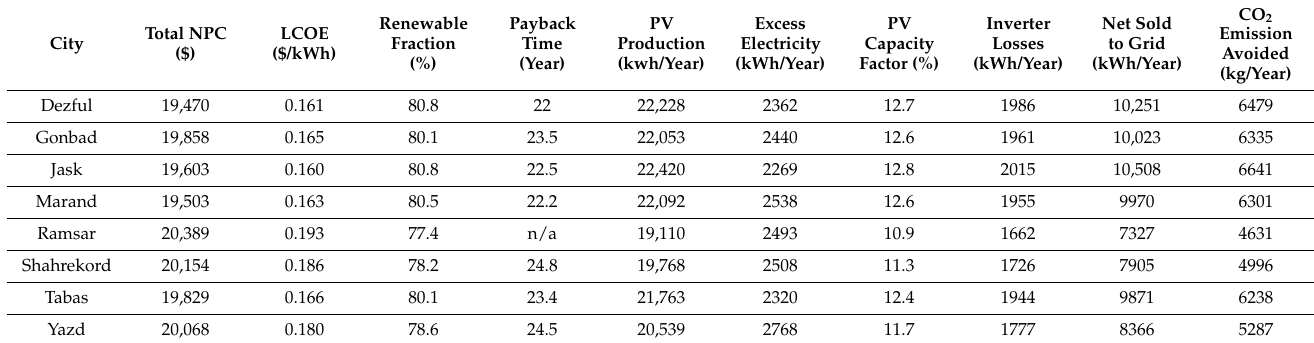
Table 7. Results of slope 90 ◦ .